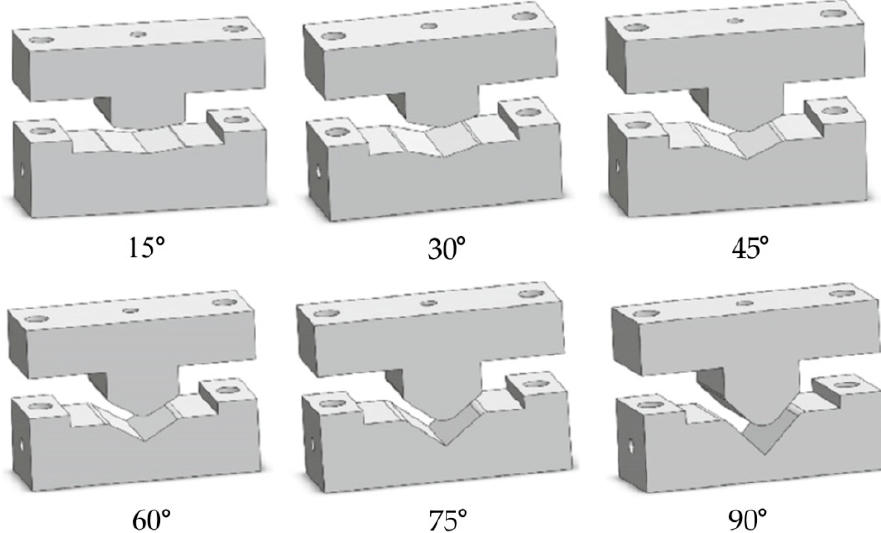
Figure 6. The punches and dies with different bending angles (reprinted with permission from [216]; copyright© 2021, King Fahd University of Petroleum & Minerals).